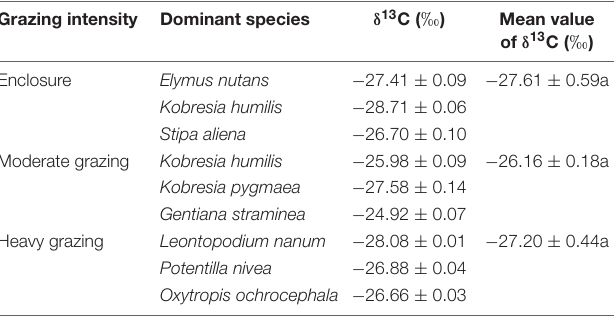
TABLE 2 | The δ 13 C value of dominant species in different grazing intensities. Grazing intensity Dominant species